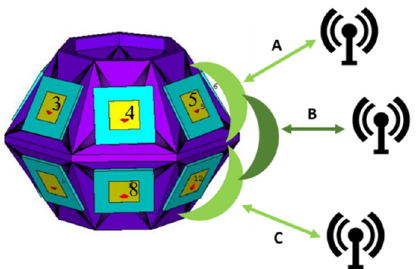
Figure 4. 3D antenna array beam-switching possibilities example.